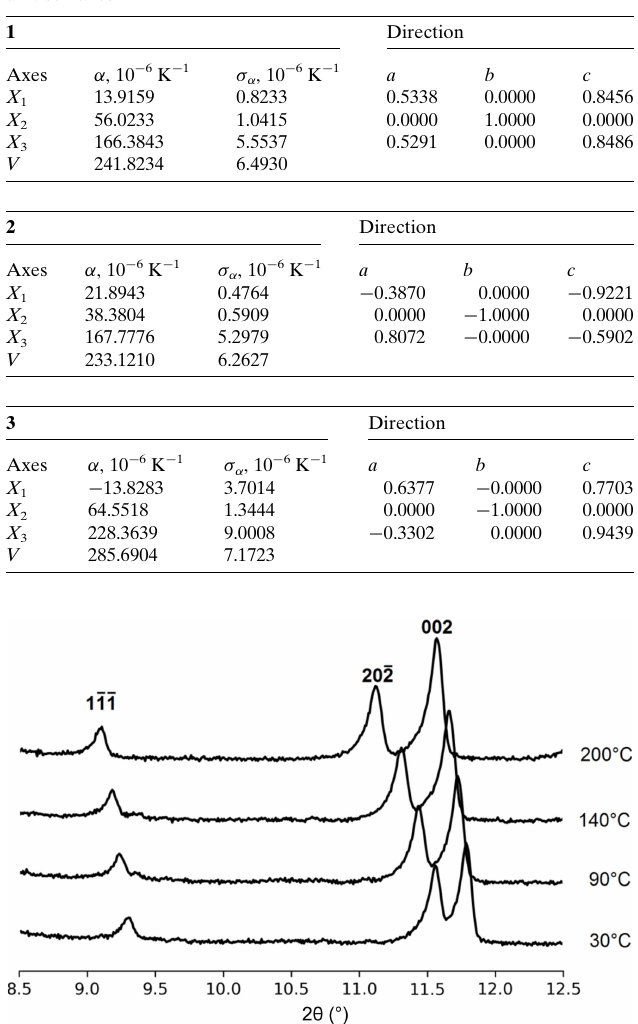
Table 1 Volume expansion coefficients and all axes expansion coefficients for 1 – 3 using the program PASCal